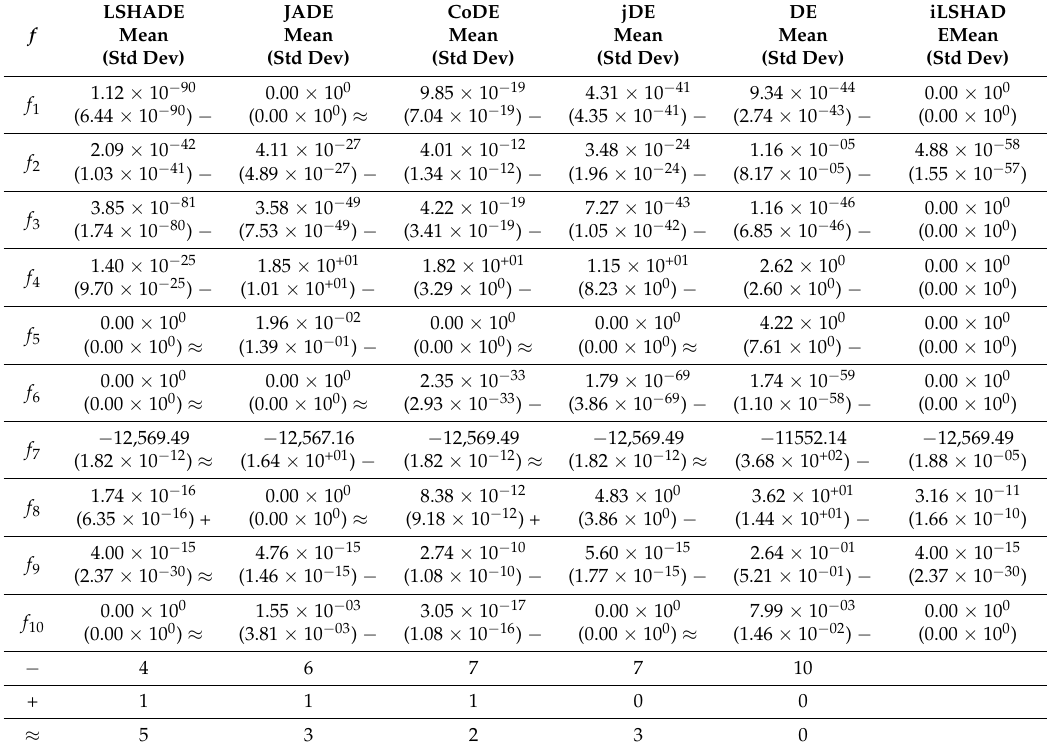
Table 3. Experimental results of 10 test functions in high